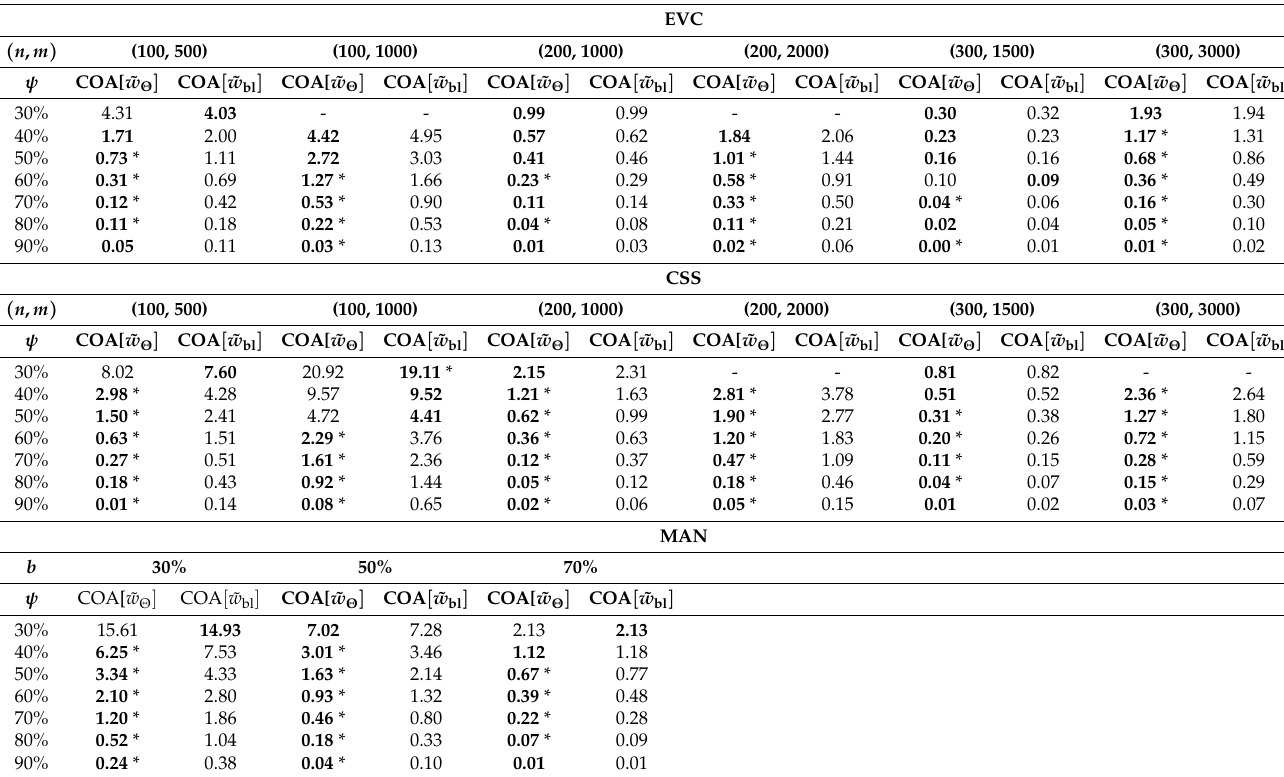
Table 2. Average optimality gaps obtained by COA using the surrogate suitability functions with ( ˜ w Θ ) and without learning capabilities ( ˜ w bl ) at different interaction